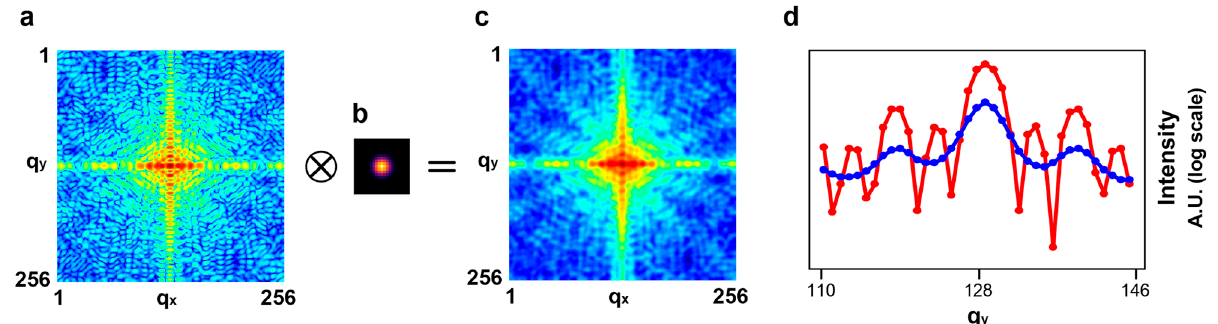
Figure 2. The method used to generate partially coherent diffractive images. ( a ) A fully coherent diffractive image created by Fourier transformation of one alphabet. ( b ) A Gaussian blur kernel with the standard deviation 2 along both the qx and qy directions, which is applied to all input images for training the model. ( c ) A partially coherent diffractive image results from the convolution between the fully coherent diffractive image ( a ) and the Gaussian blur kernel in ( b ). ( d ) Line-outs through the center of the diffraction images in ( a , c ), denoted by red and blue lines, respectively.